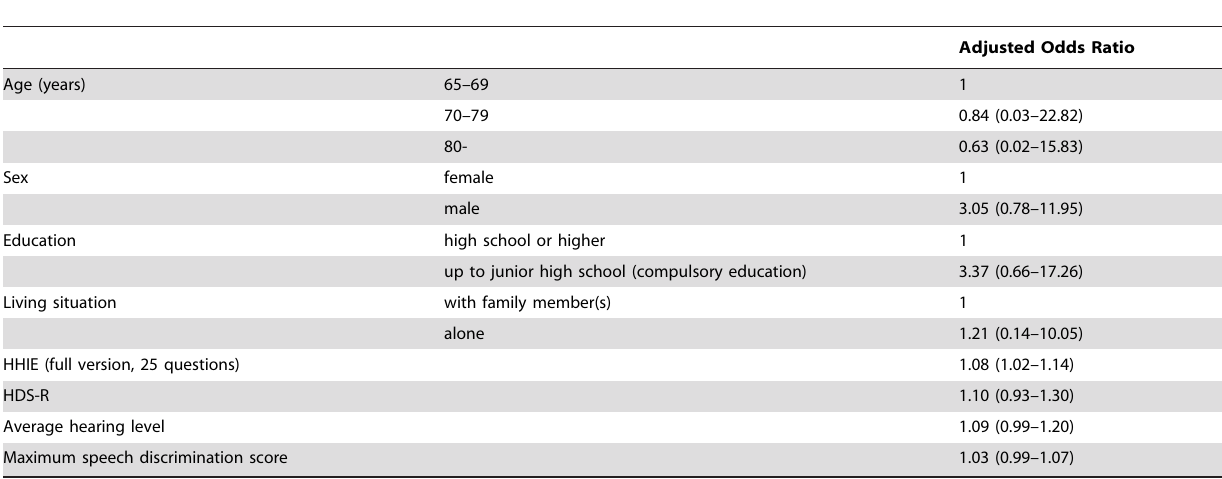
Table 4. Factors influencing hearing-aid usage in 63